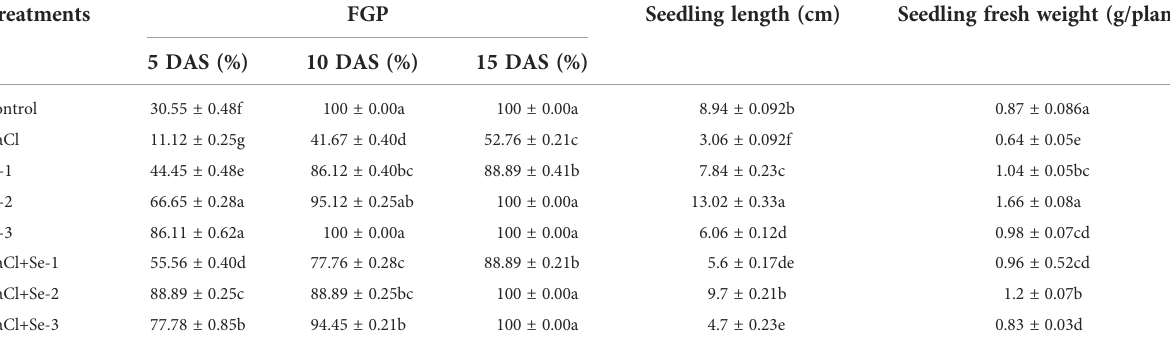
Data presented are the mean ± SD of fi ve replications. Different letters denote signi fi cant differences between treatments at p ≤ 0.05. NaCl = 200 mM NaCl; Se-1 = 75 m mo L − 1 Se; Se- 2 = 100 m mo L − 1 Se; Se-3 = 125 m mo L − 1 Se. FGP, fi nal germination percentage; DAS, days after sowing; C,